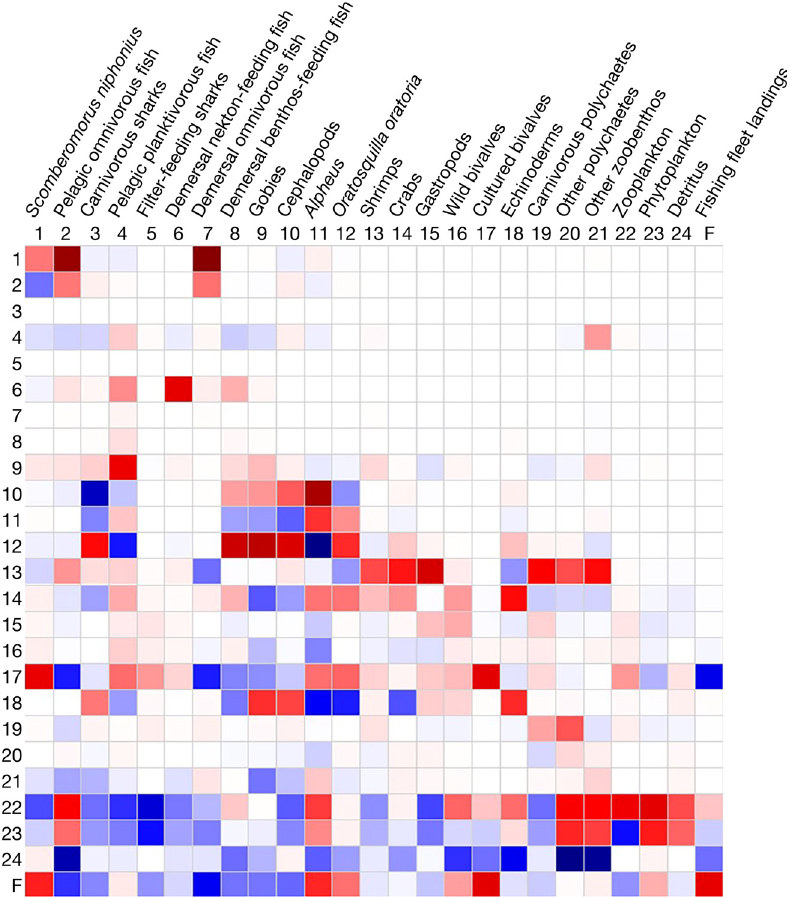
Fig. 4. Mixed trophic impact plot of the bal- anced model. An infinitesimally small in- crease in biomass of the groups listed to the left affects the groups listed across the top. The level of impact is shown by the colour and shading of the boxes. Darker blue boxes denote a more negative impact; darker red boxes denote a more positive impact. The impacts of fishing fleet landings (F) are also